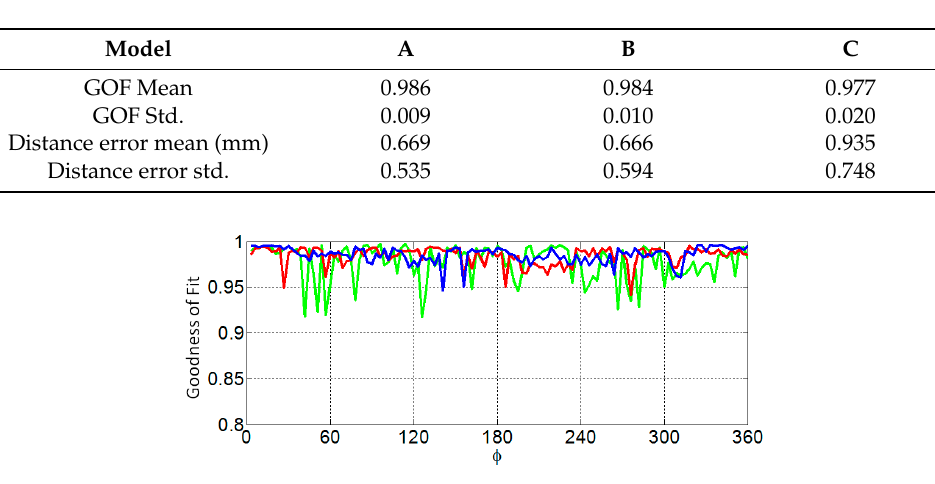
Figure 6. Estimated profile (red) fitted to measured laser data plotted with reference profile (blue) of numerical model for: ( a ) A, ( b ) B, and ( c ) C. Table 1. Mean and standard deviation of profile over 120 profiles.